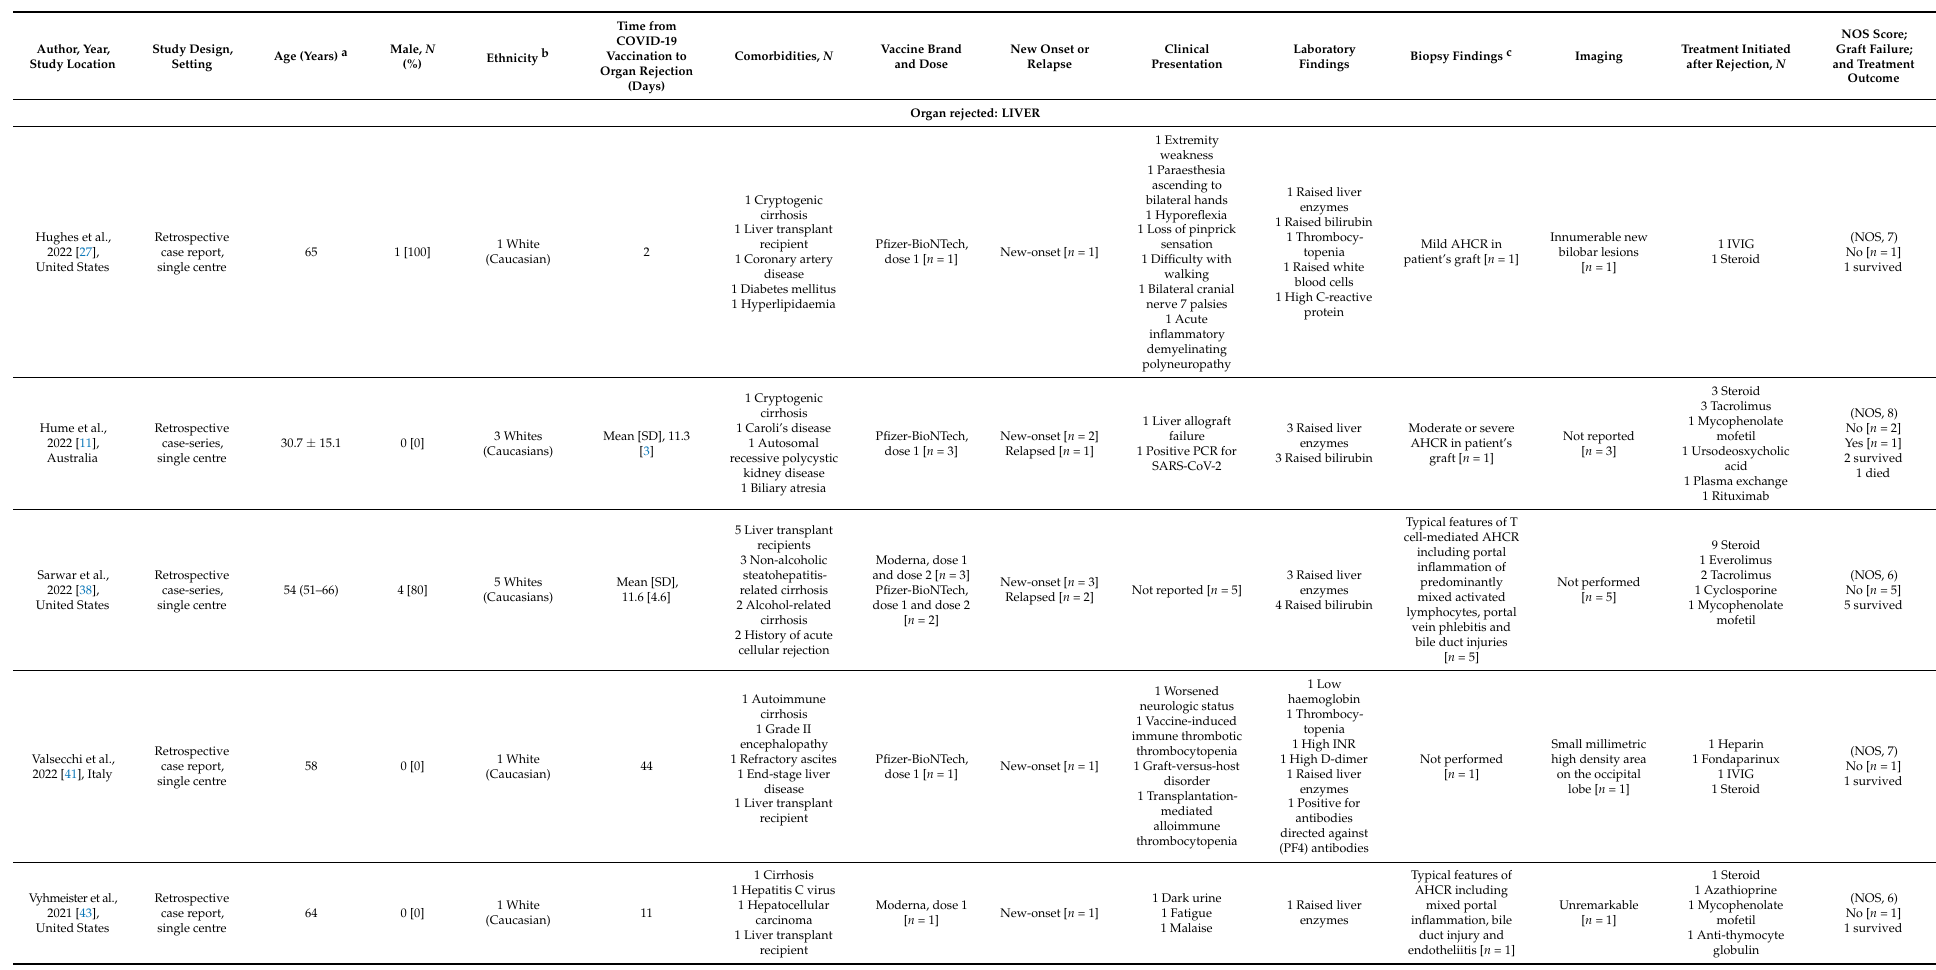
Table 1. Summary of the characteristics of the included studies with evidence on organ rejection post-COVID-19 vaccination ( n = 32 studies),